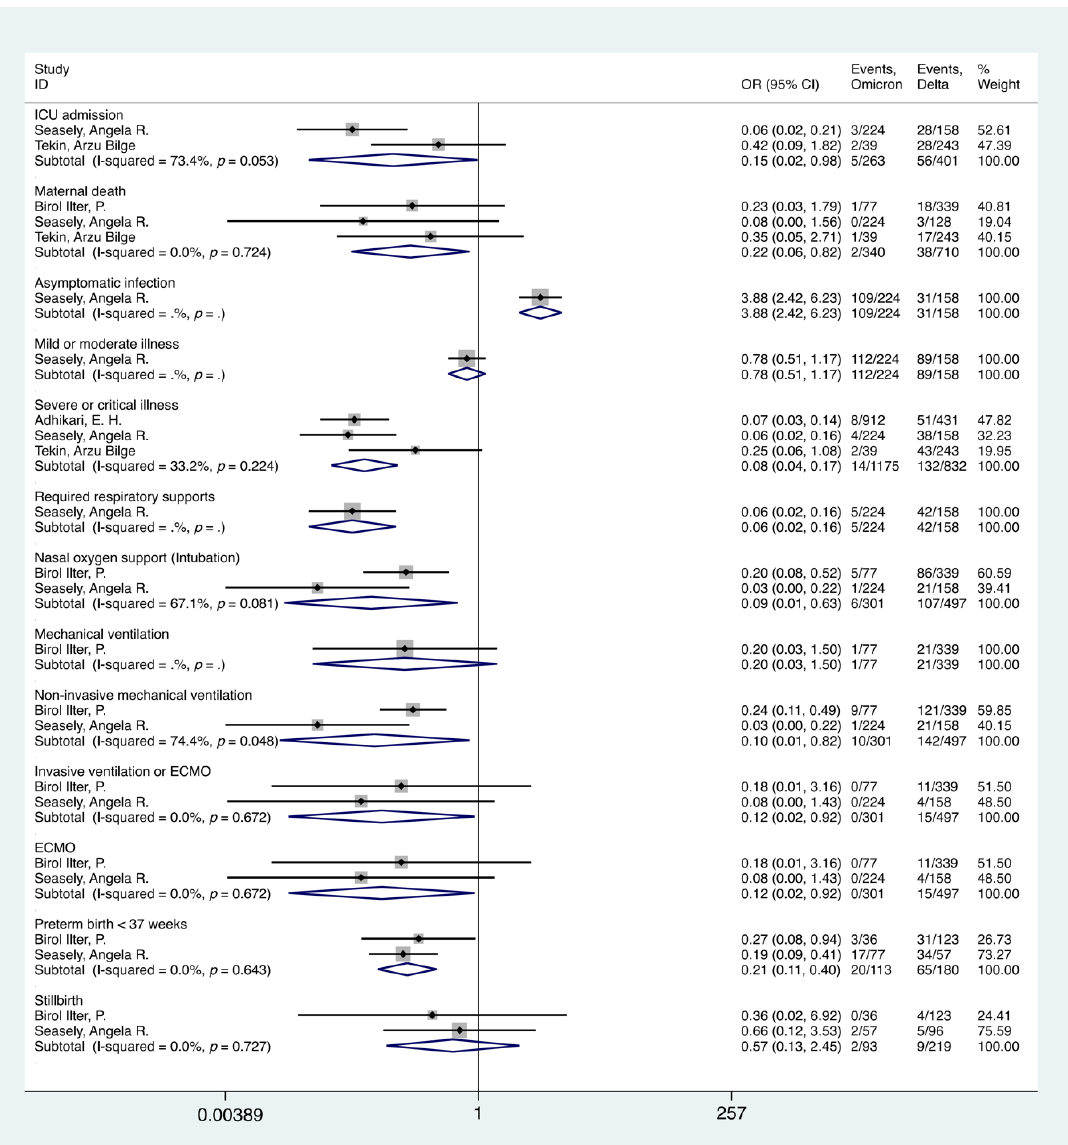
Figure 3. Forest plot of maternal and perinatal outcomes of Omicron or Delta SARS-CoV-2 variant infections during pregnancy. NOTE: Weights are from random effects analysis.